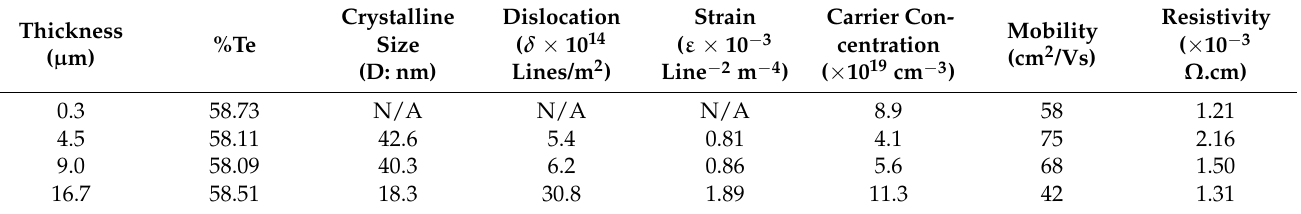
Table 1. Thickness, percentage of Te, lattice stain and crystalline size of deposited Sb 2 Te 3 films with different film thicknesses.